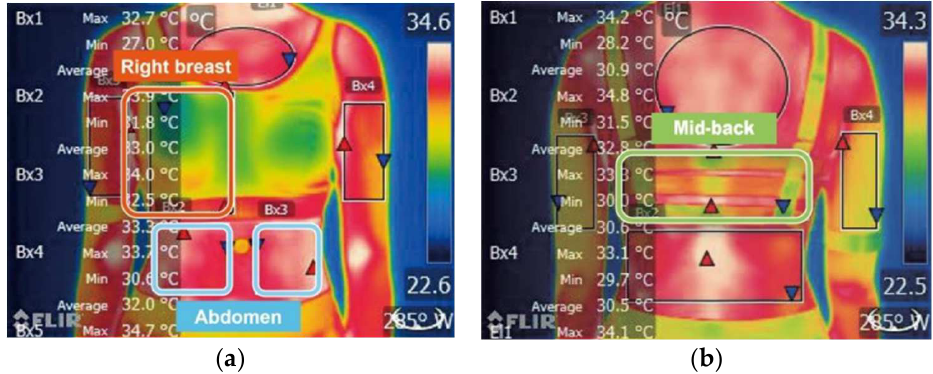
Figure 3. Skin temperature (FLIR) locations with regions of interest (ROIs) at ( a ) Front view, right breast and abdomen; and ( b ) Back view, and mid-back.